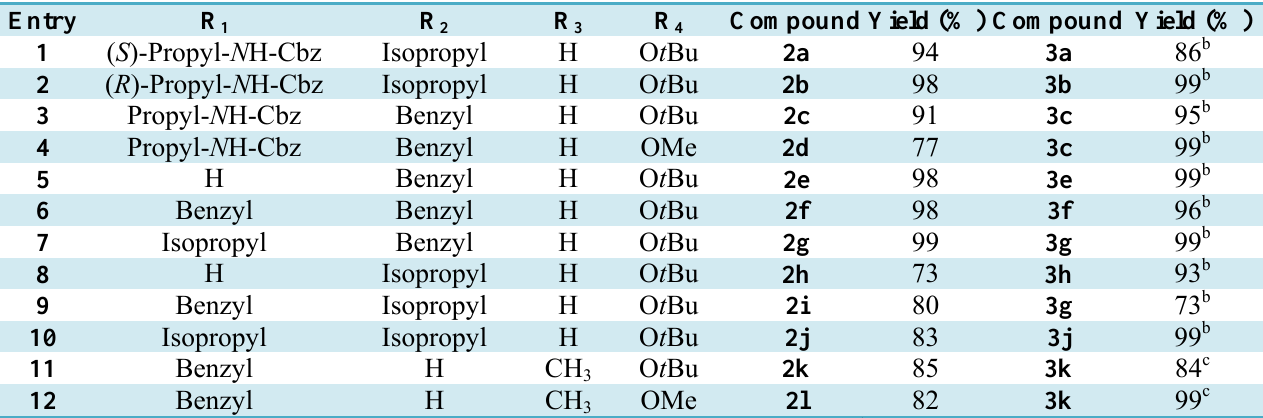
a Reactions performed in a monomode microwave CEM Discover apparatus; b Crude yield (pure by NMR); c Isolated yield after chromatography